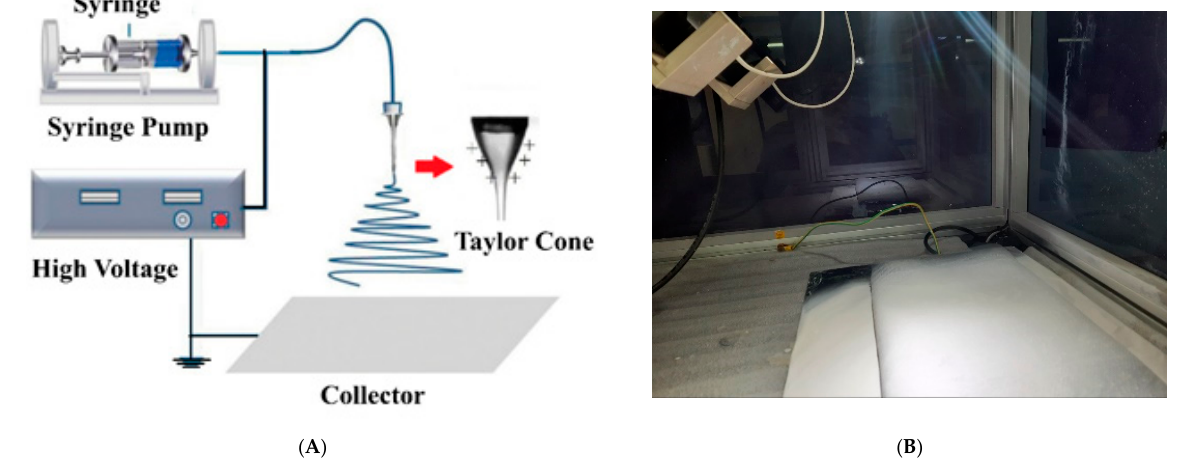
Figure 2. ( A ) A schematic diagram of the electrospinning process [26] and ( B ) A photo of the fabricated membrane before the post-treatment .